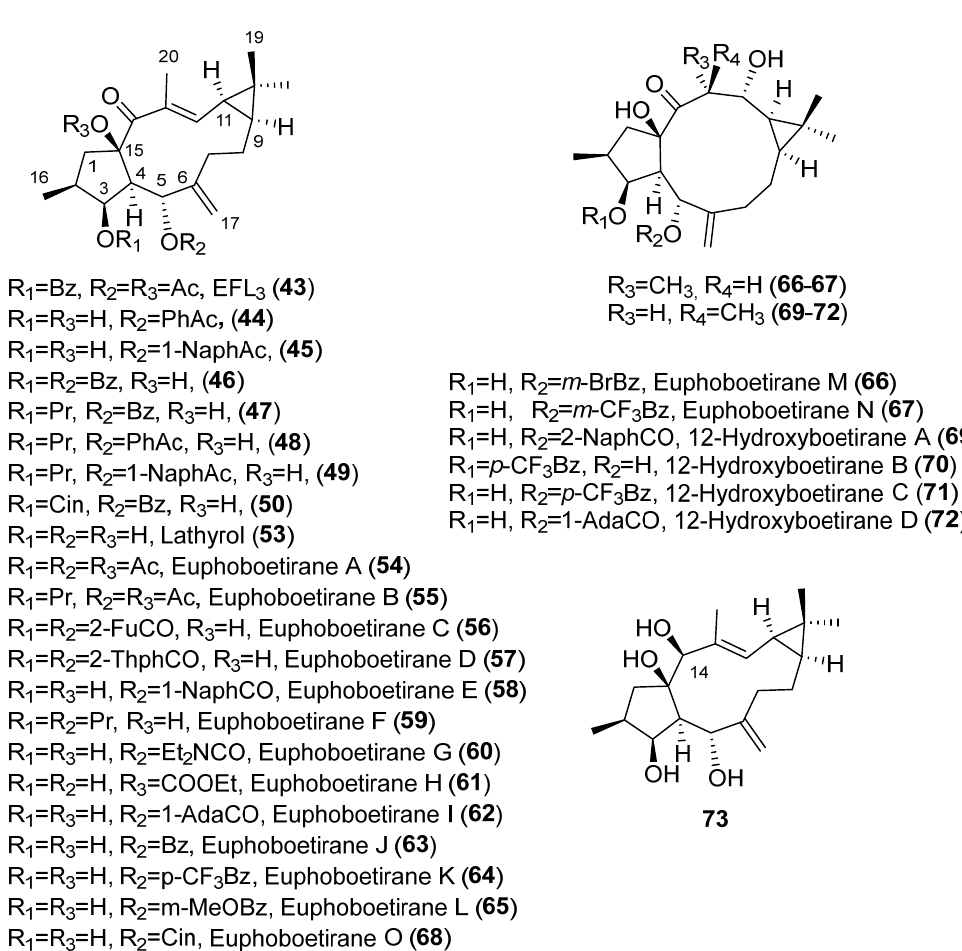
Figure 6. Chemical structures of bioactive lathyrol derivatives, euphoboetiranes and